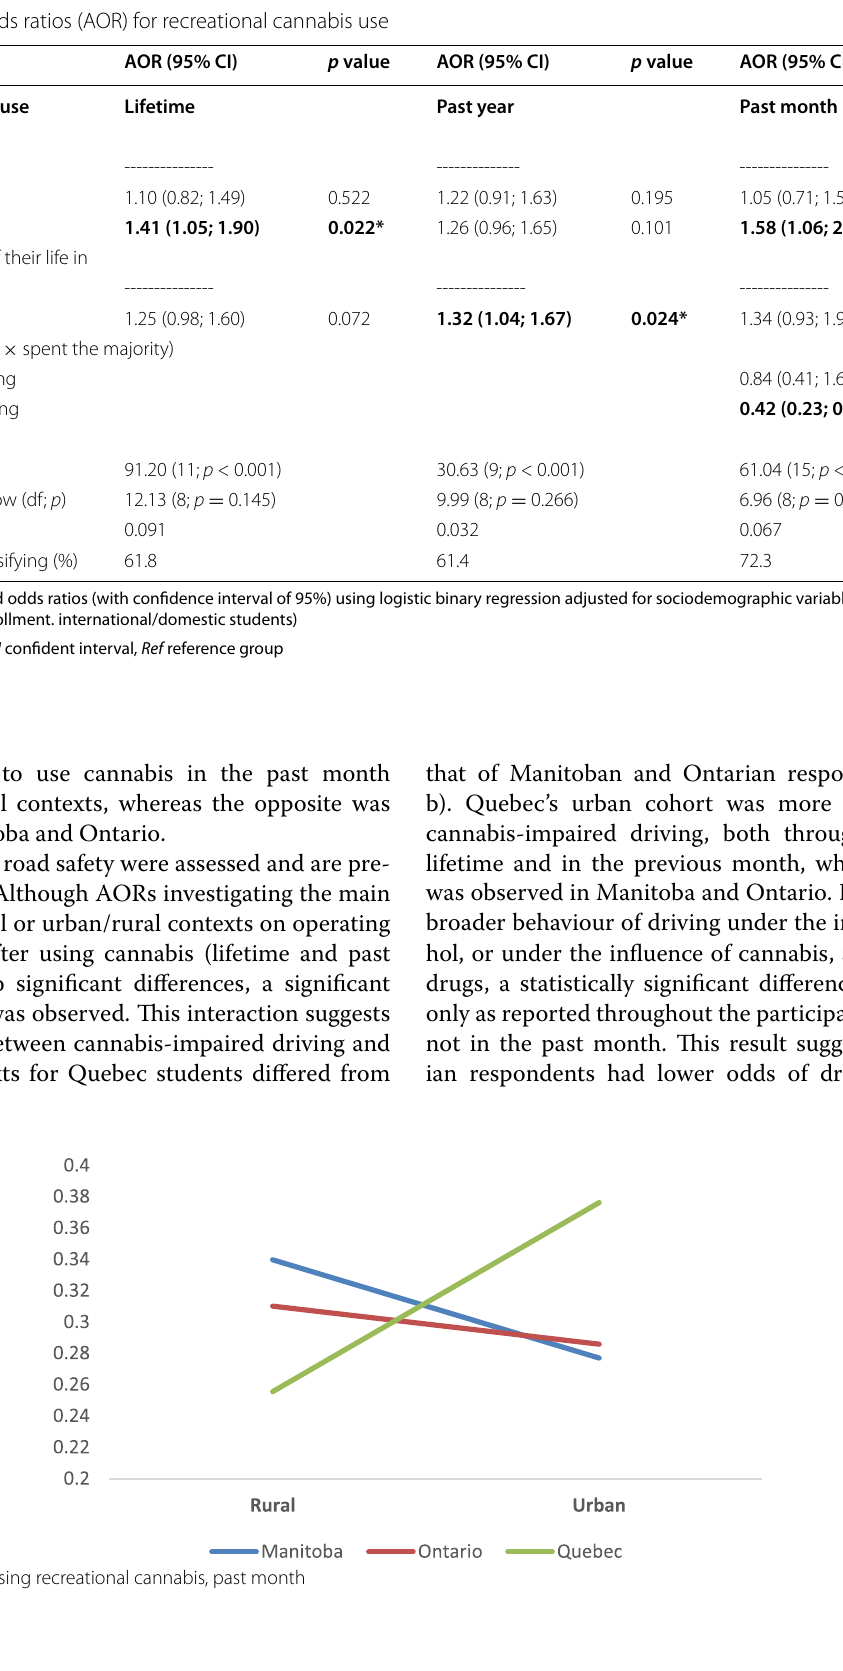
Table 4 Adjusted odds ratios (AOR) for recreational cannabis use